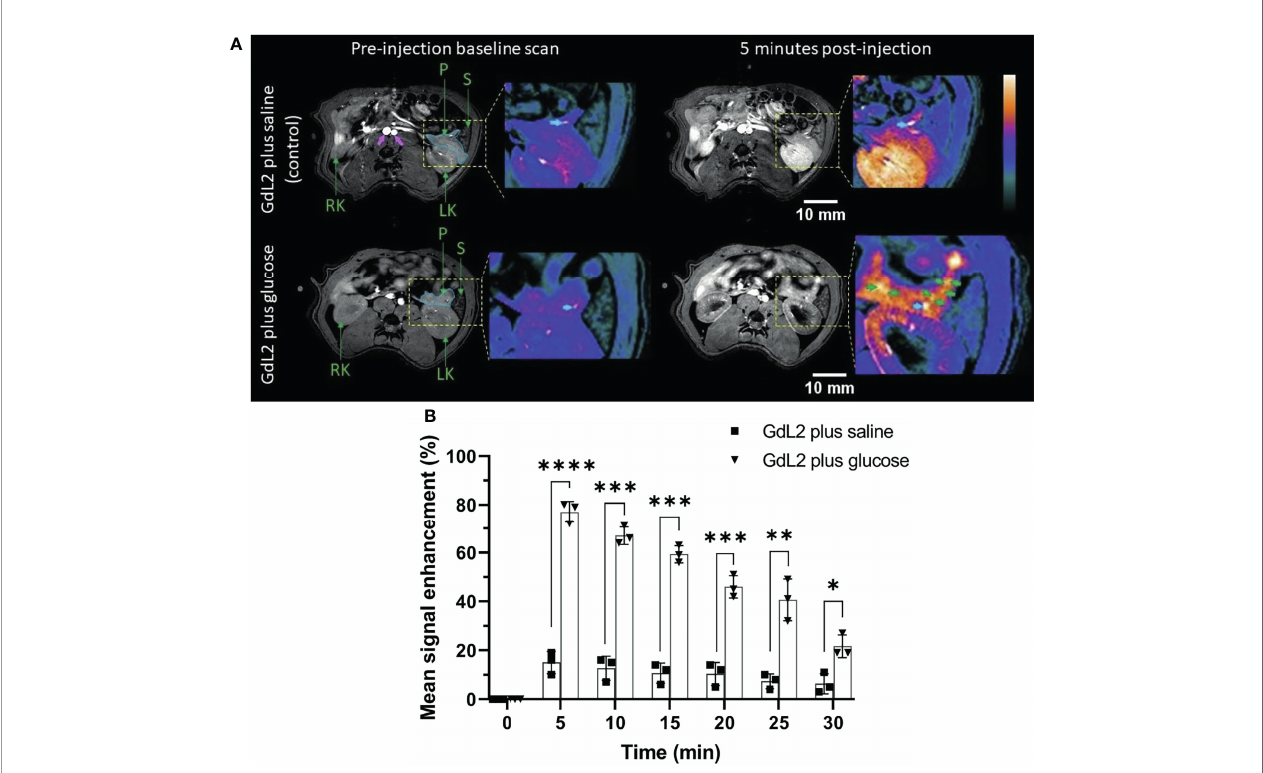
FIGURE 1 | (A) Axial T 1 -weighted pre- and 5 min post-contrast MRI of rat pancreas after administration of GdL 2 plus saline (top row) or GdL 2 plus glucose (bottom row). The pancreas is outlined with solid cyan in pre-contrast images. The pancreatic tail, left kidney, and major blood vessels (pink arrows) are enhanced post- injection. The cyan arrow represents the splenic vein. [P: pancreas, S: spleen, LK: left kidney, RT: right kidney]. (B) Pancreas signal enhancement over time in rats injected with either GdL 2 plus glucose or GdL 2 plus saline. Rats injected with GdL 2 plus glucose display signi fi cantly higher signal enhancement across all time points (p < 0.0001) compared to rats injected with GdL 2 plus saline (p values varied from *p < 0.05, **p < 0.01, ***p < 0.001, ****p < 0.0001). The individual data points in (B) are shown as the mean ±